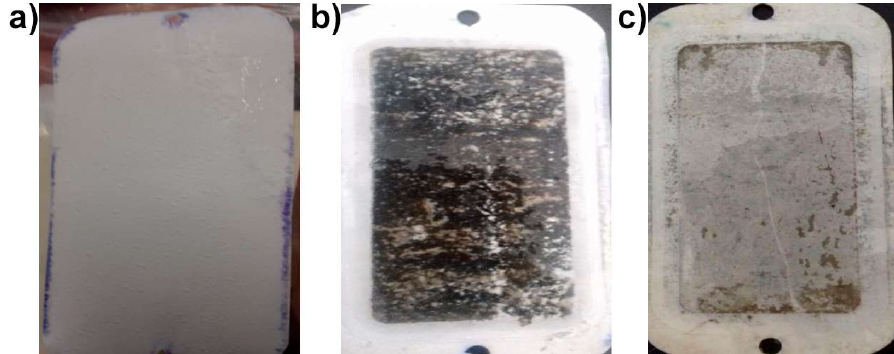
Figure 8. Photographs of the RO membranes before and after the accelerated biofouling tests: ( a ) membrane before the test, ( b ) bacterial growth on uncoated membrane, and ( c ) bacterial growth on FeNP-coated membrane.